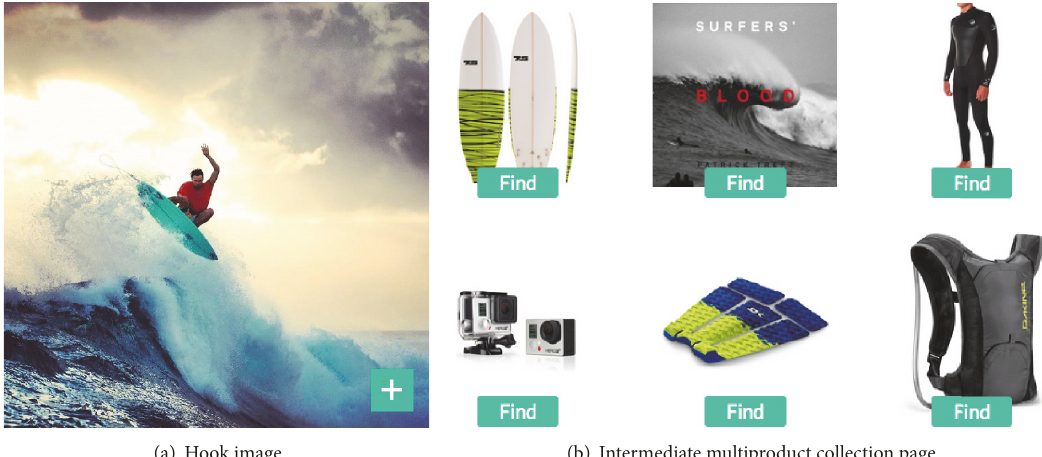
Figure 13: Products of a sample landscape Hook image. Clicking on the Hook image (a) from social network platforms directs consumers to (b) an intermediate page with several products to explore.